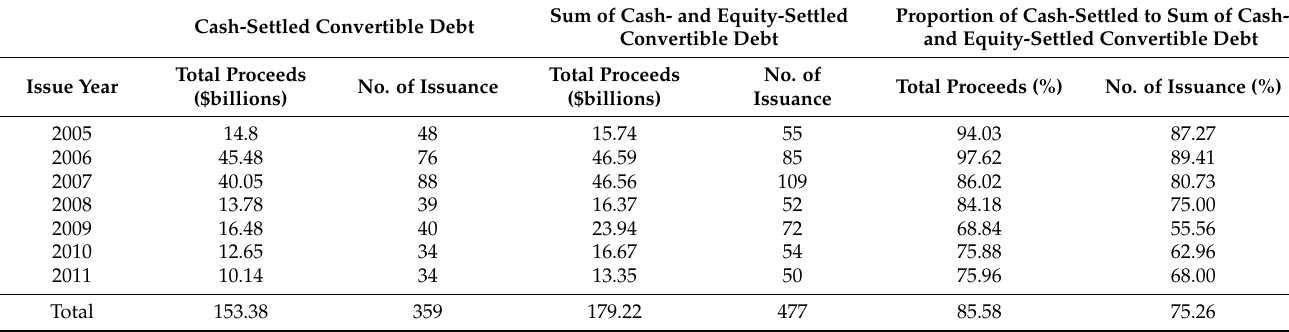
Table 2. Total proceeds and issuances of convertible